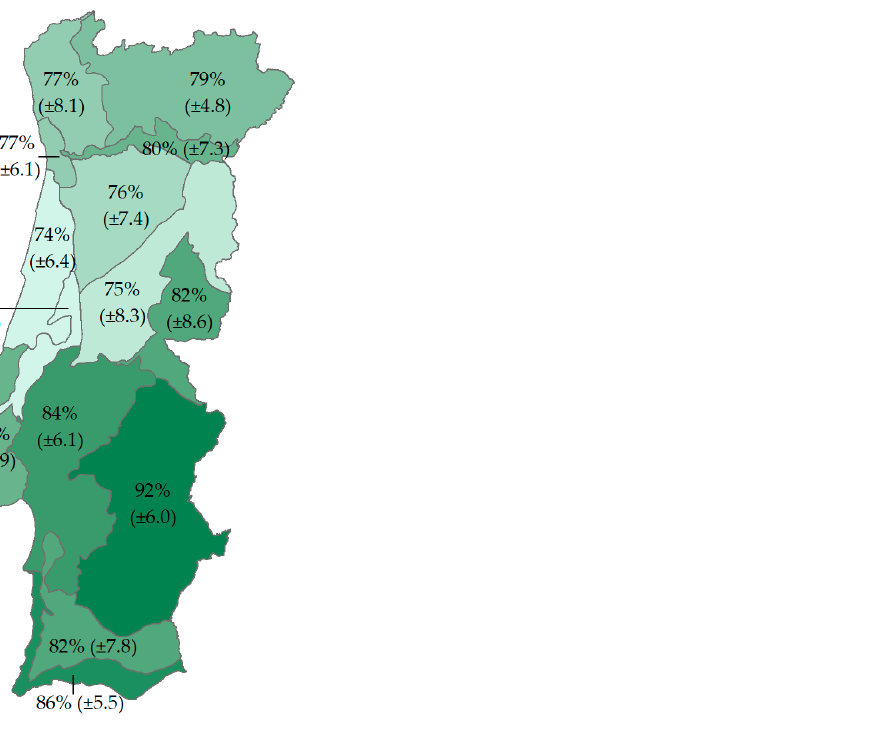
Figure 7. Overall accuracy in the mapping zones. Darker tones of green mean more accuracy.